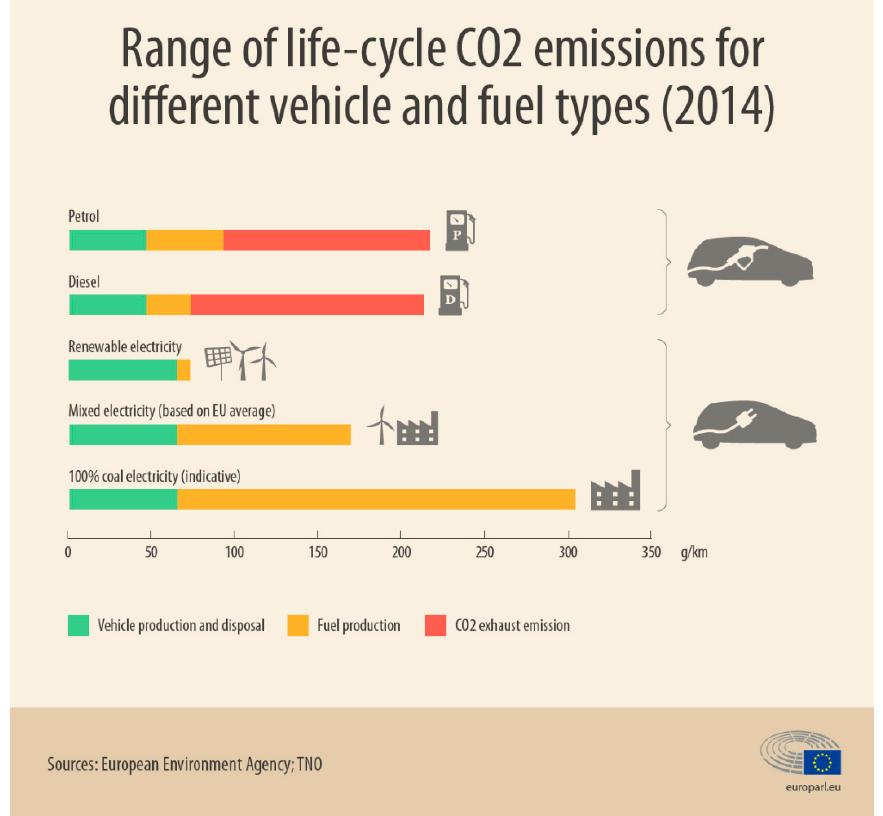
Figure 2. Life-cycle CO 2 emissions as a function of the energy source [13] with data from [14].